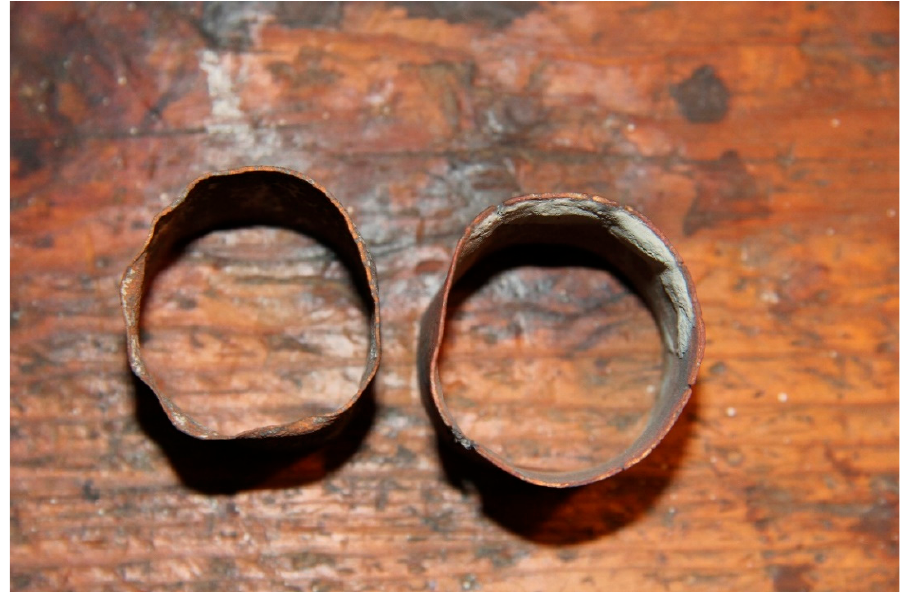
Figure 2. Asbestos liner inside casting cylinder. Source: Dental Museum. Faculty of Dentistry. University of Granada (2021).